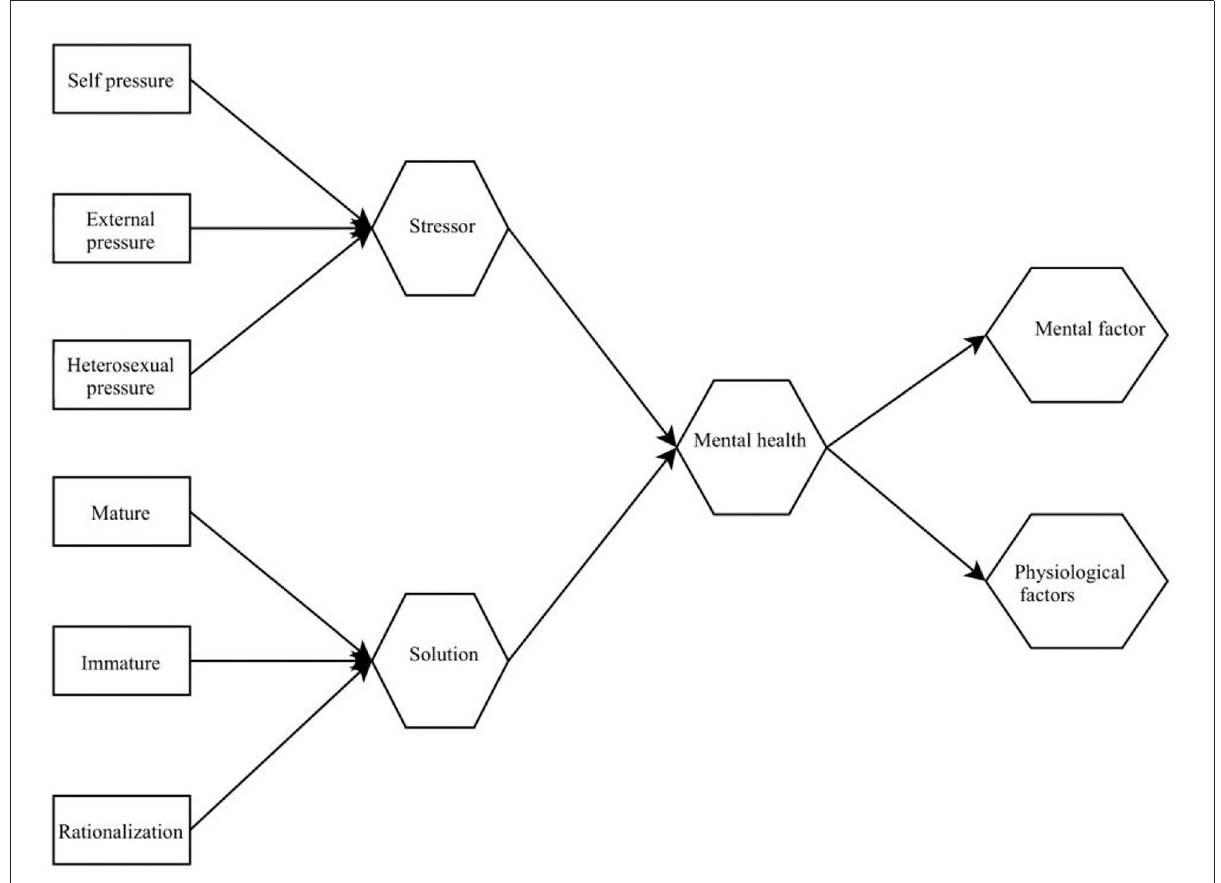
FIGURE7 Basic pathways of stressors and coping